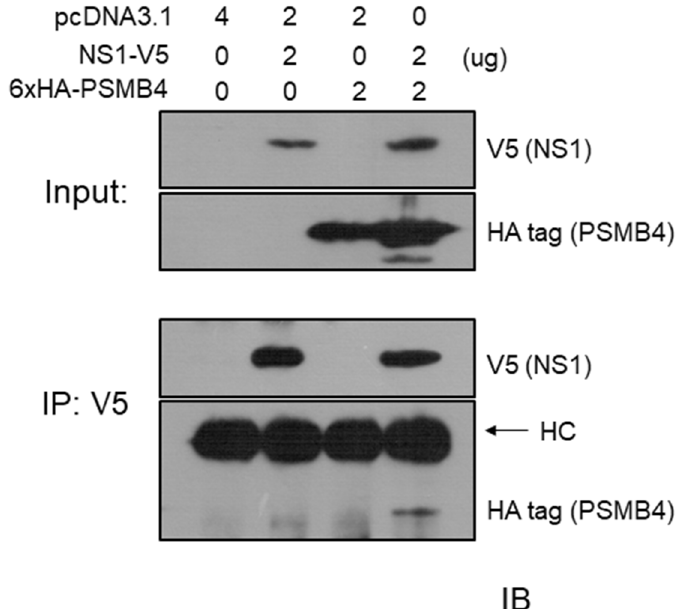
Figure 2. Co ‐ immunoprecipitation experiments on IAV NS1 and PSMB4 proteins in A549 cells. A549 cells were transfected with a plasmid allowing expression of the PSMB4 protein with the HA tag, the NS1 protein with the V5 tag or co ‐ transfected with these two plasmids. Cell lysates were analyzed directly (input) by Western blot (IB; immunoblot) or were immunoprecipitated (IP) with the anti ‐ V5 antibody prior to Western blotting against V5 or HA tag.